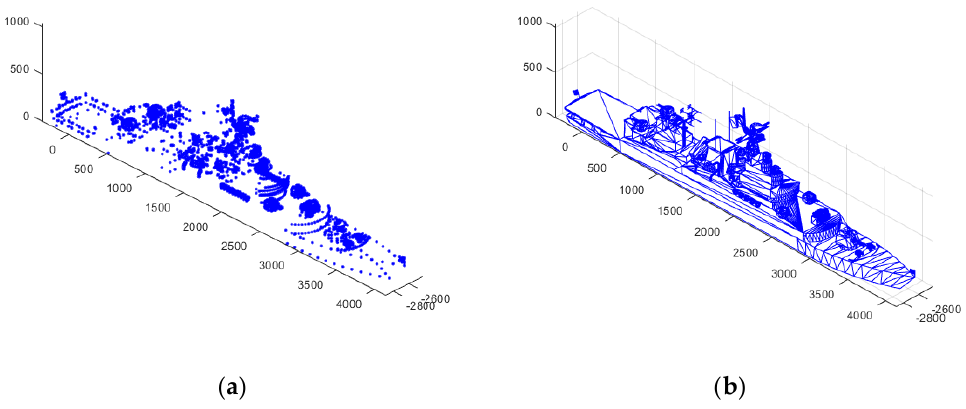
Figure 2. ( a ) A ship’s point cloud model. ( b ) A ship model with triangles. In formula (2), p j represents each point in the point cloud, and t k represents the order in which the Different colors were given to the different types of ships, such as red or green for cargo ships and gray or black for warships. Then, we provided the right amount of reflection on the landscape surface of the ship model, and adjusted the light and contrast. After the above steps, the final ship models were generated, which are shown in Figure 3.